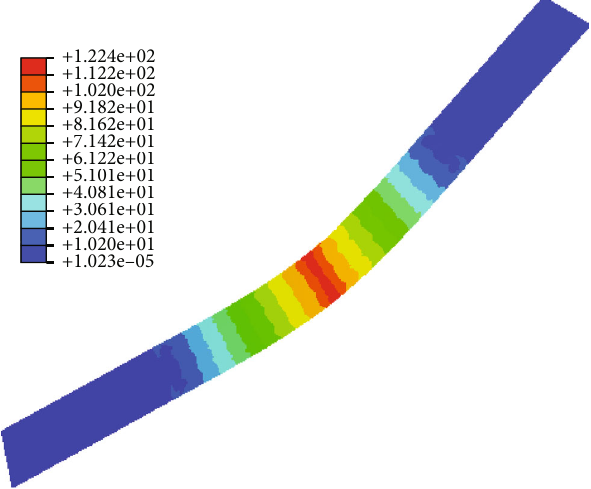
Figure 11: Stress (( S , miss/MPa)) nephograms of honeycomb core belong to actual model.